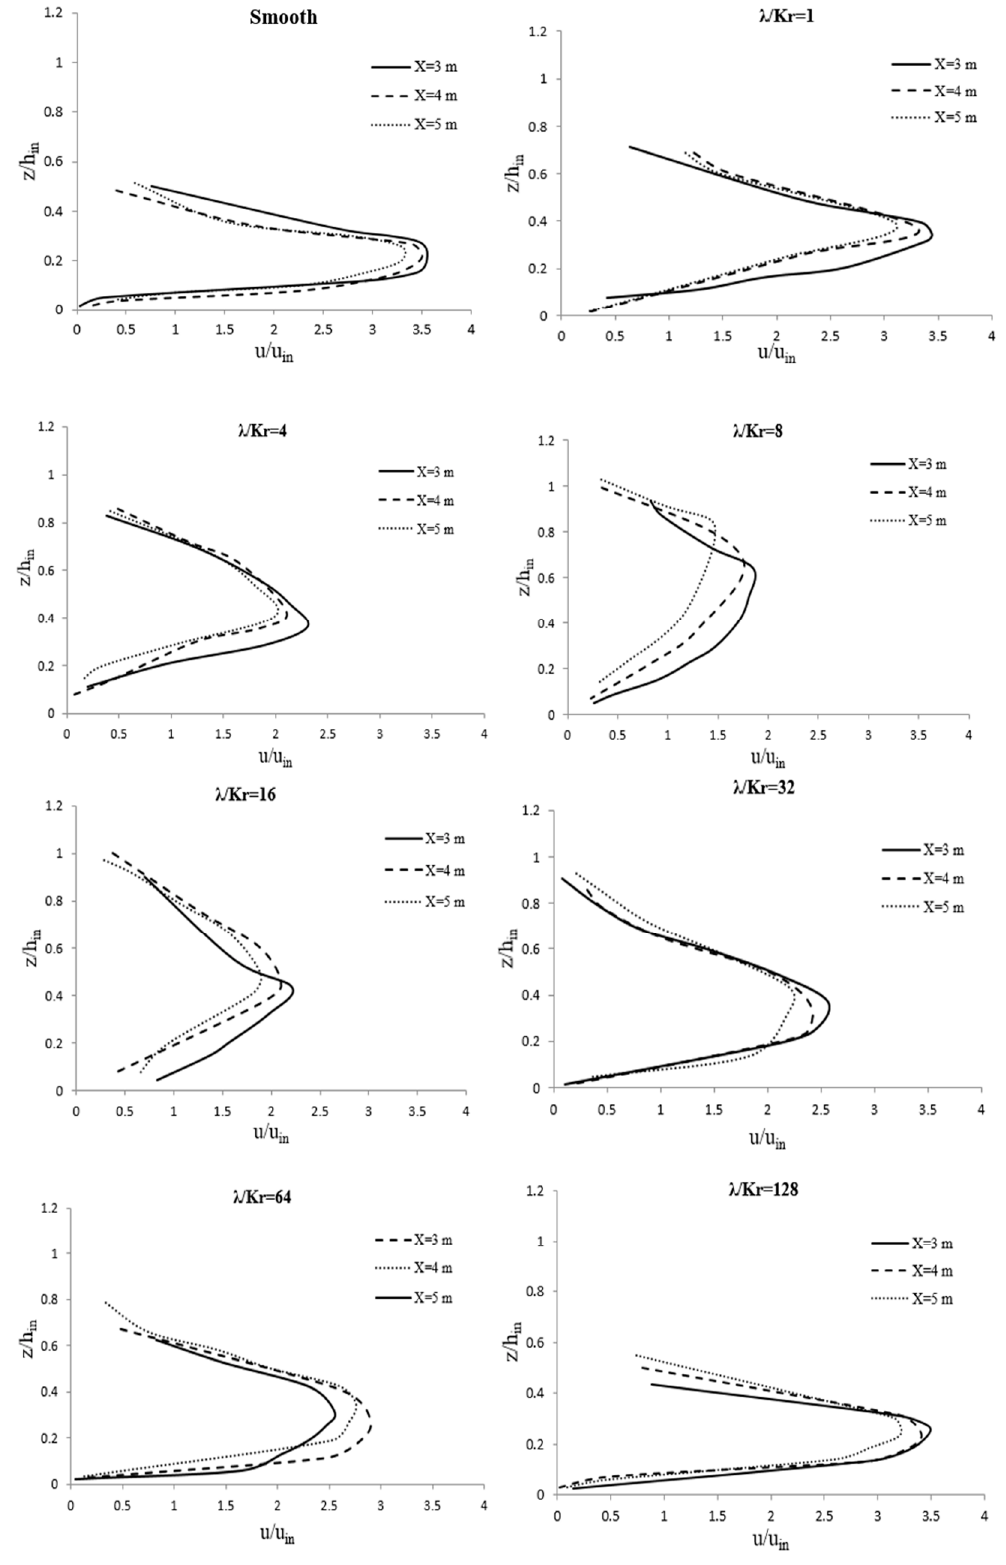
Figure 7. Velocity profiles at different locations for smooth and rough beds corresponding to h in = 7 cm, C in = 15 g/L, Q in = 0.5 L/s, and S = 0.25%.